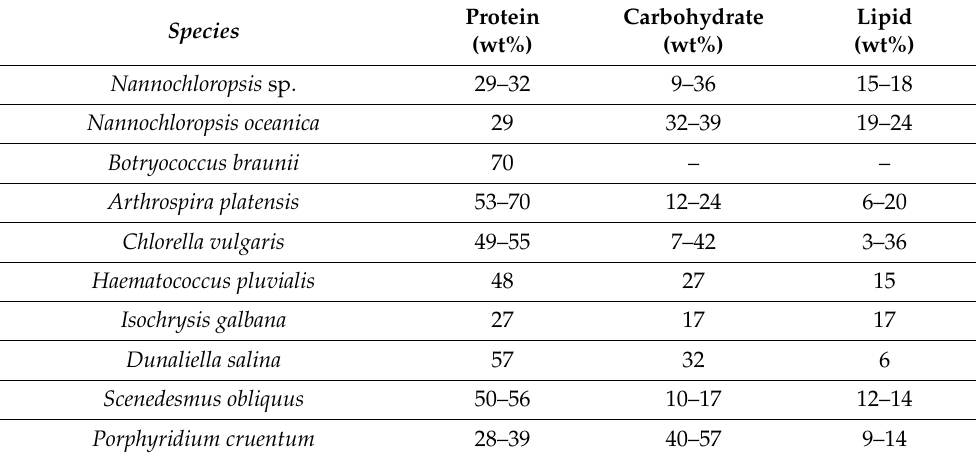
Table 2. Macronutrient composition of commercially important microalgae (extracted from